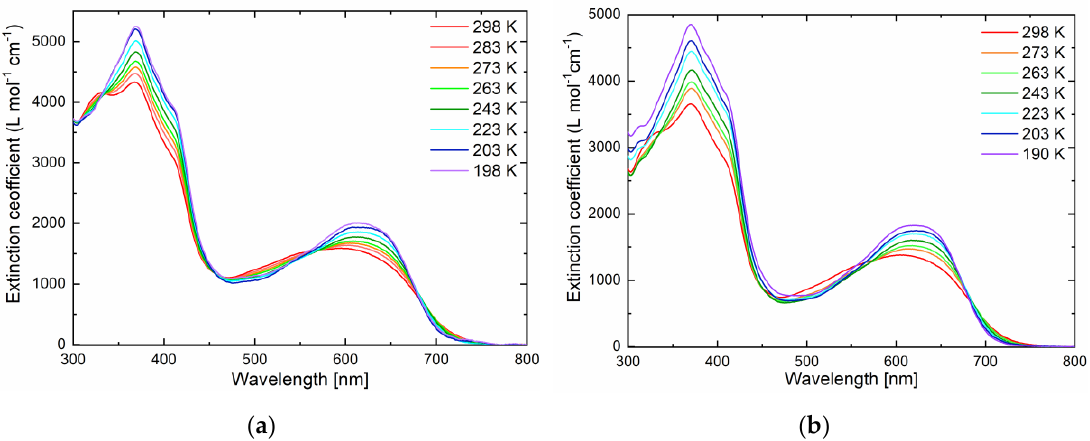
Figure 8. Variable temperature UV-Vis characterization of complex 1 ( a ) and 2 ( b ).